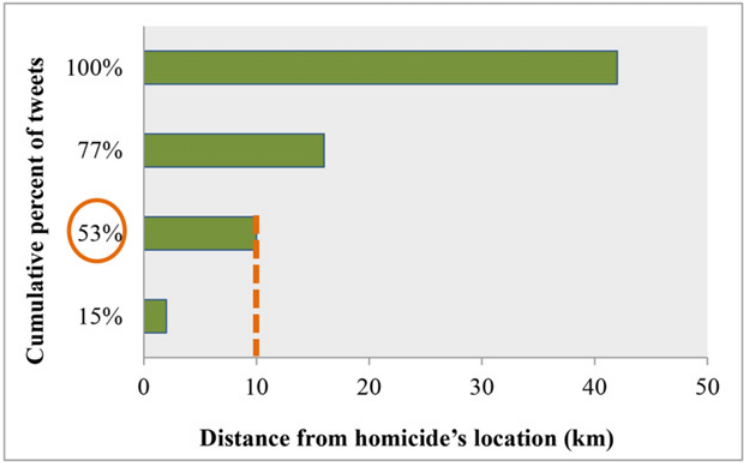
Fig 5. The cumulative percent of crime tweets at different distance intervals. Distance is defined as the distance from users ’ estimated home locations to the crime incidents ’